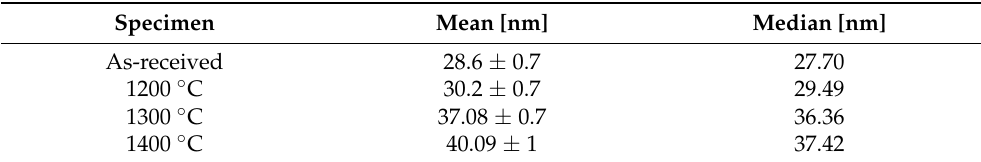
Figure 4. A comparison of oxide-size normalized distribution for as-received state and aged samples at 1200, 1300 and 1400 °C for 30 min. Table 2. Average values and median of diameters for as-received state and 30-min aging at 1200, 1300 and 1400 °C.